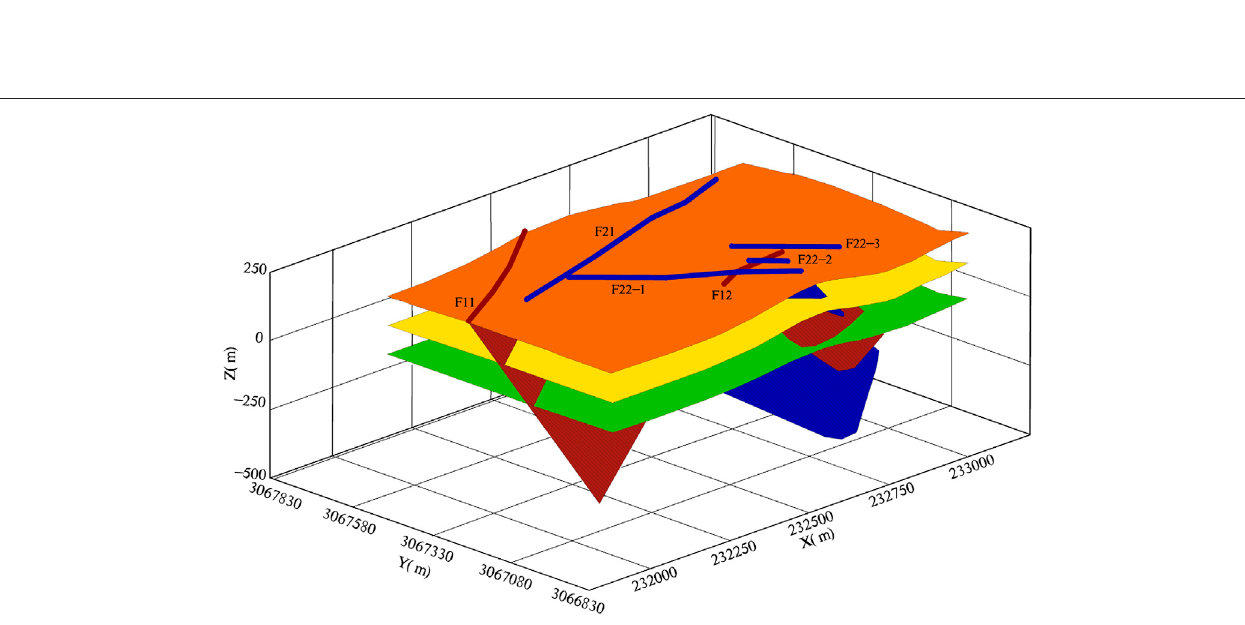
Frontiers in Earth Science |